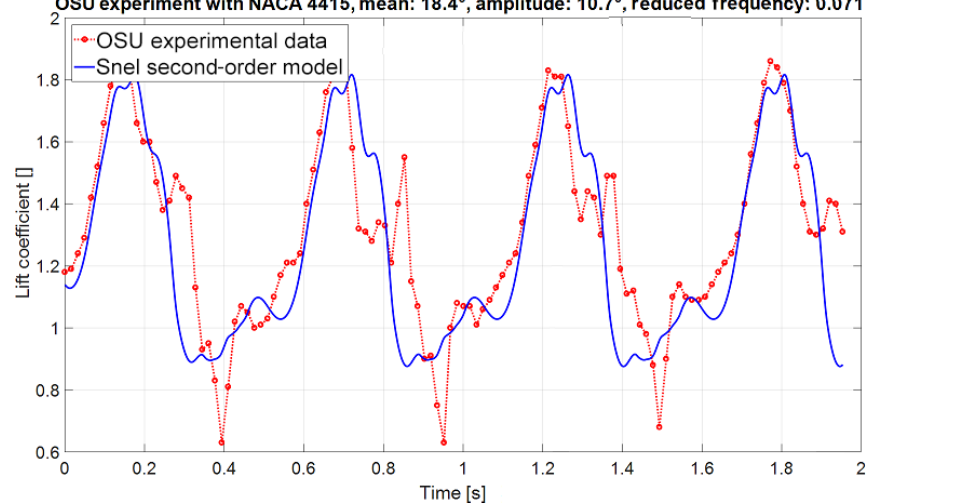
Figure 3. Lift coefficient time of the initial Snel model (NACA 4415 aerofoil with mean angle of attack of 18.4 ◦ , amplitude of 10.7 ◦ , and reduced frequency of